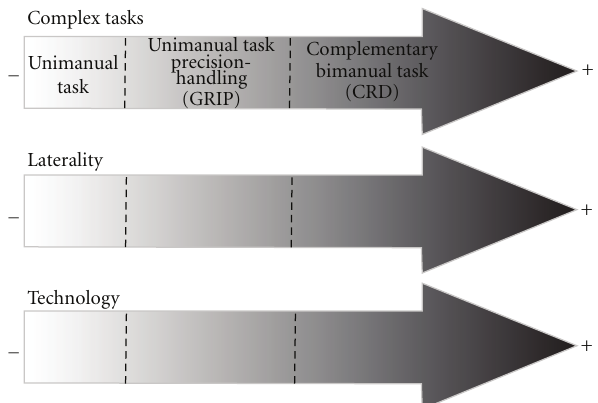
Figure 2: Relationships between complex tasks, hand laterality, and technological